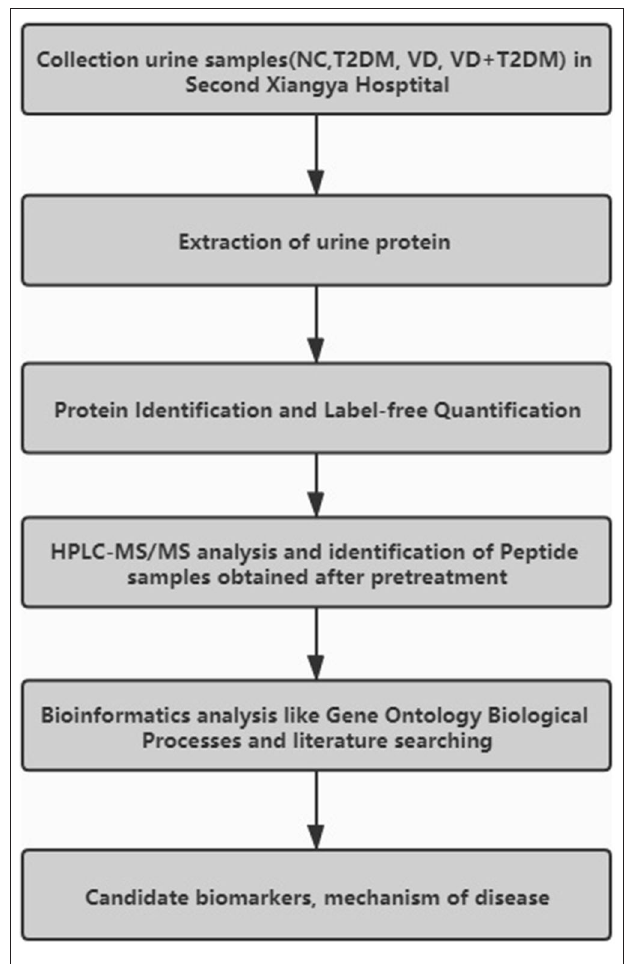
FIGURE 1 | The workflow of the experimental procedures.